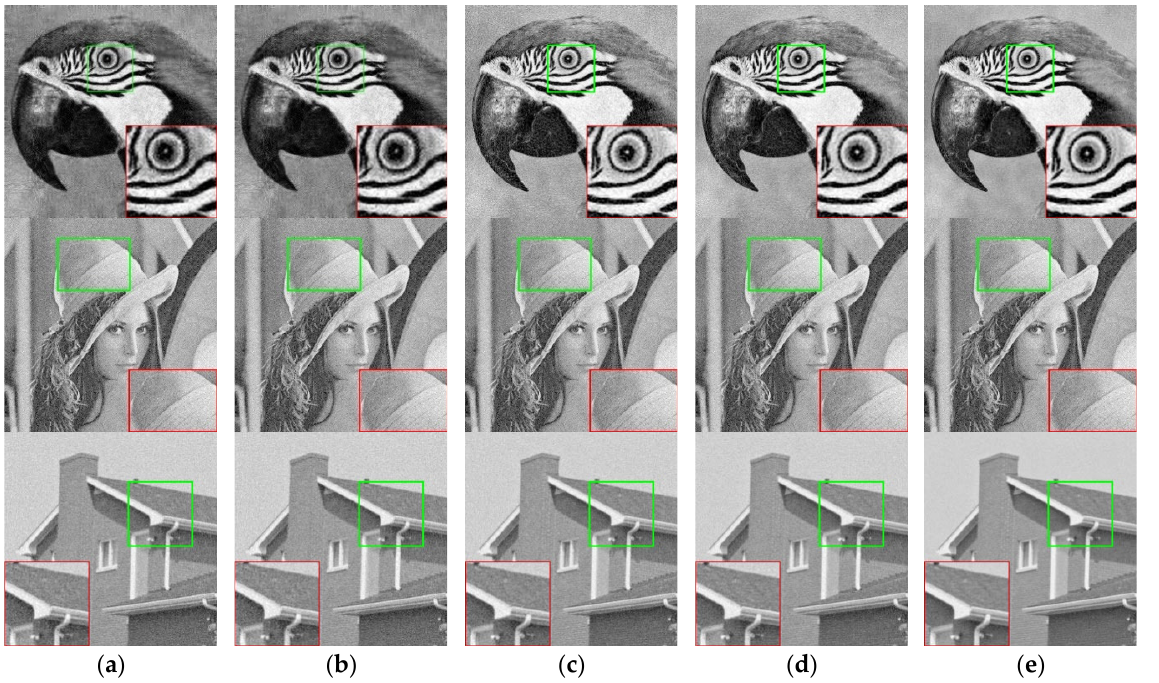
Figure 5. Denoising results of the images on the Set12 dataset by different methods. ( a ) KPN [3]. ( b ) CBDNet [24]. ( c ) SRNet [14]. ( d ) WCNN [13]. ( e ) Ours.